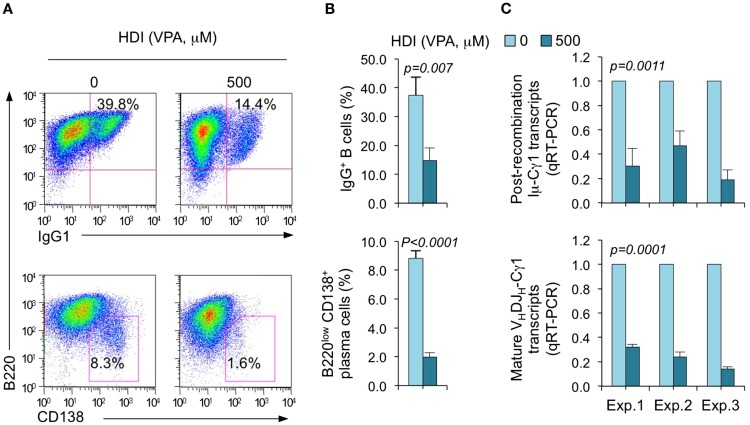
HDI inhibits B cell CSR and plasma cell differentiation. Purified spleen B cells were stimulated with LPS plus IL-4 in the presence of HDI (VPA, 500 μM) or nil. (A) Surface expression of B220 and IgG1 was measured by flow cytometry 96 h after the stimulation, Data are one representative of three independent experiments. (B) The average percentage of IgG1+ B cells and B220low CD138+ plasma cell in nil or HDI-treated cells in the three experiments. (C) Mature VHDJH-Cγ1 transcripts and post-recombination Iμ-Cγ1 transcripts, both hallmarks of completed CSR, were analyzed by qRT-PCR and normalized to Cd79b transcripts in B cells stimulated for 60 hours, measured by qRT-PCR and normalized to Cd79b transcripts. Data are from three independent experiments. p values, paired t-test.